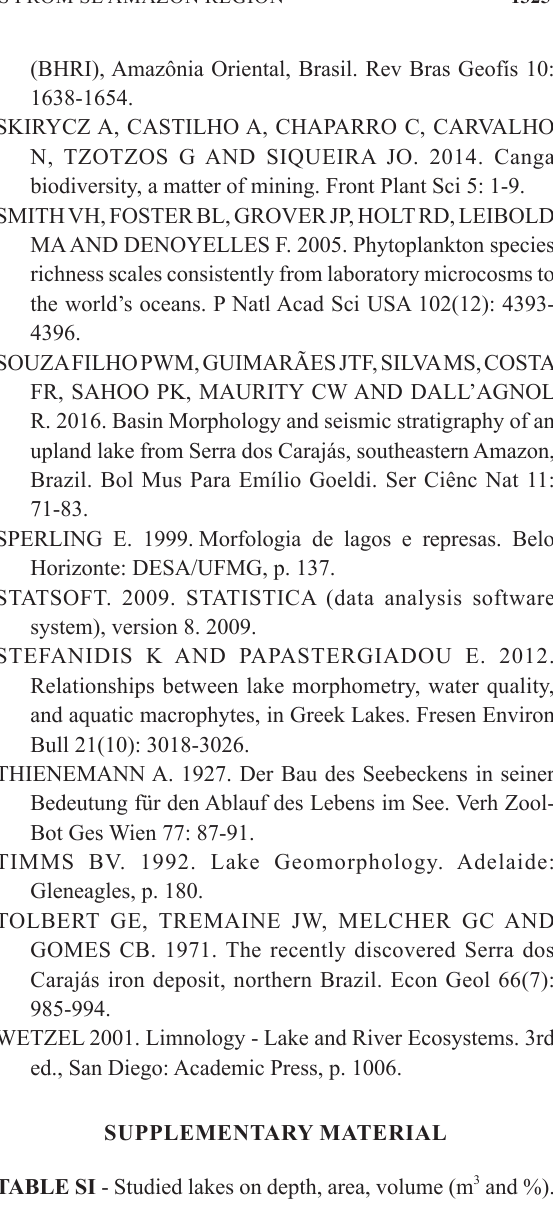
TABLE SI - Studied lakes on depth, area, volume (m 3 and